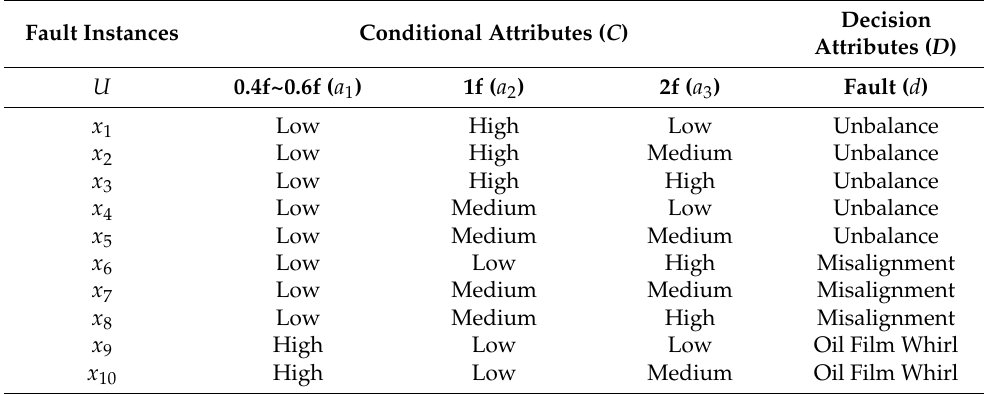
Table 1. Decision table for vibration fault diagnosis of a steam turbine. Fault